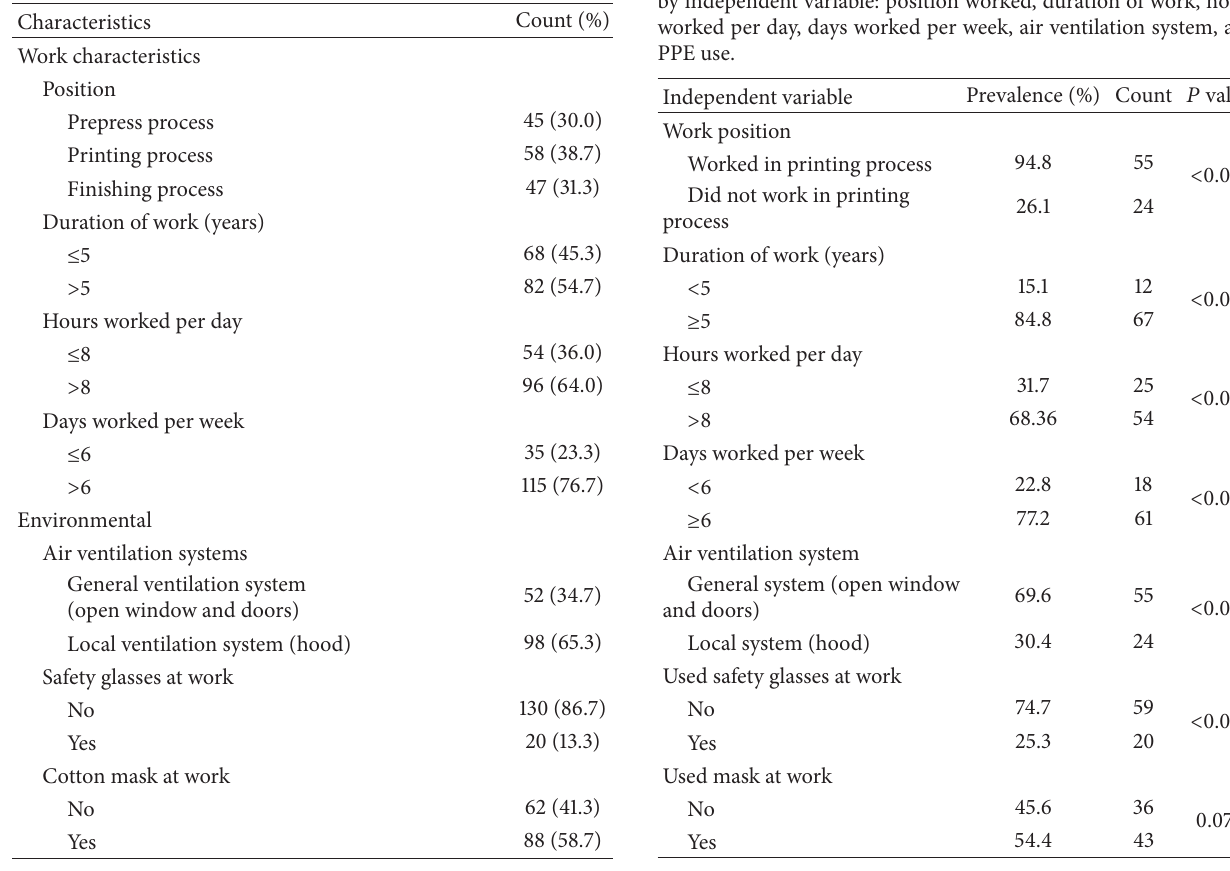
Table 2: Work characteristics, work environment ( 𝑛 = 150).